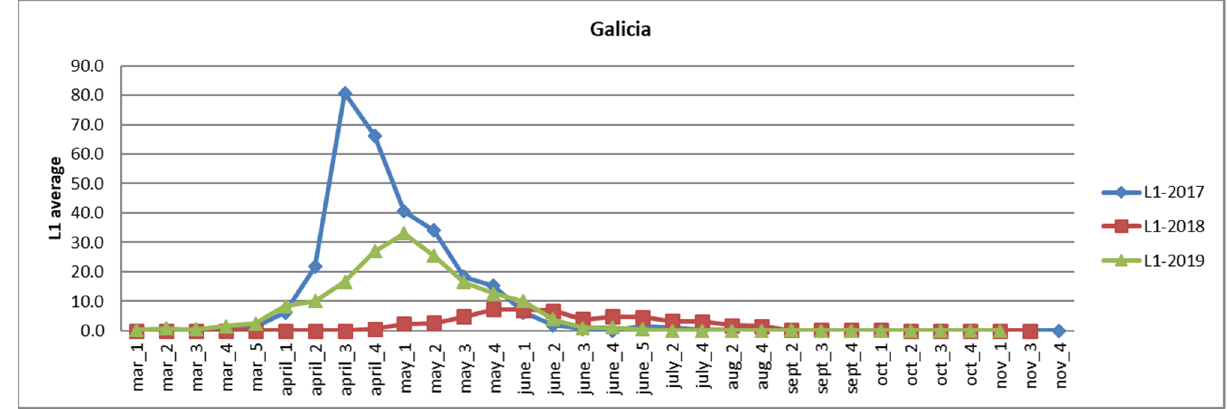
11 of 18 Figure 7. Mean values for total adults according to the week of the sampling month (visit). The insect infestation had a greater presence in 2017, with a high abundance of adults from July to September, and lower in subsequent years. The number of adults in 2018 and 2019 was very similar. The mean value of total adults per plot evaluated in spring 2020